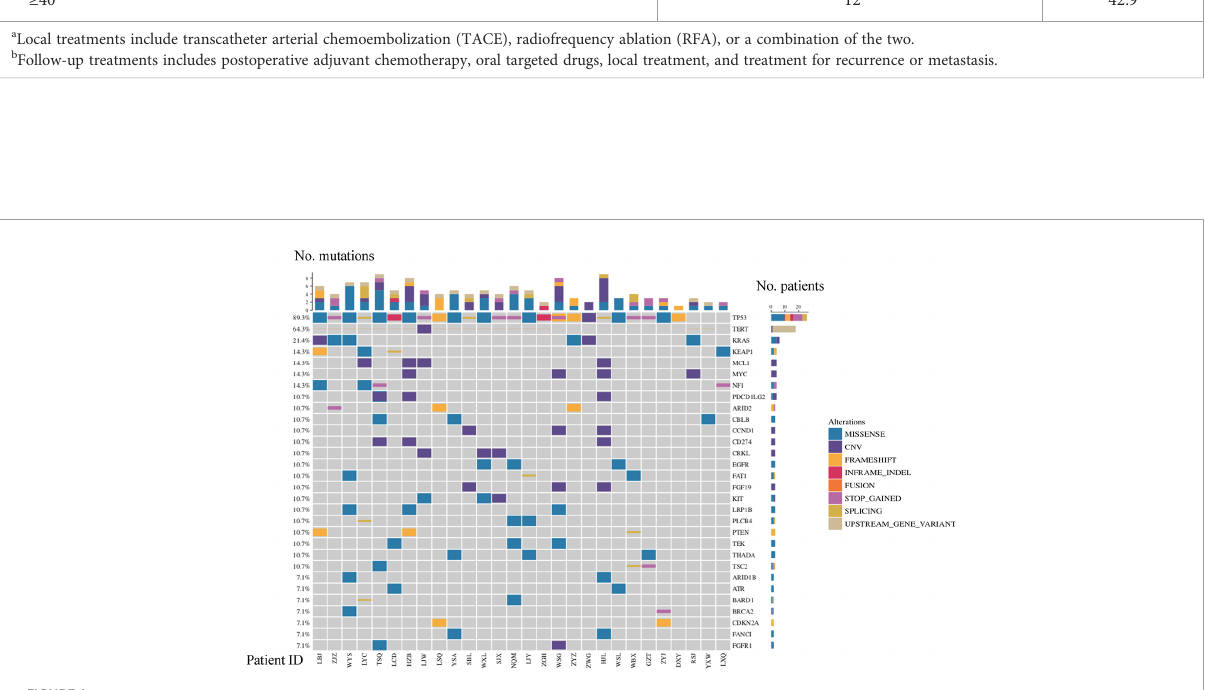
FIGURE 1 Mutational landscape of